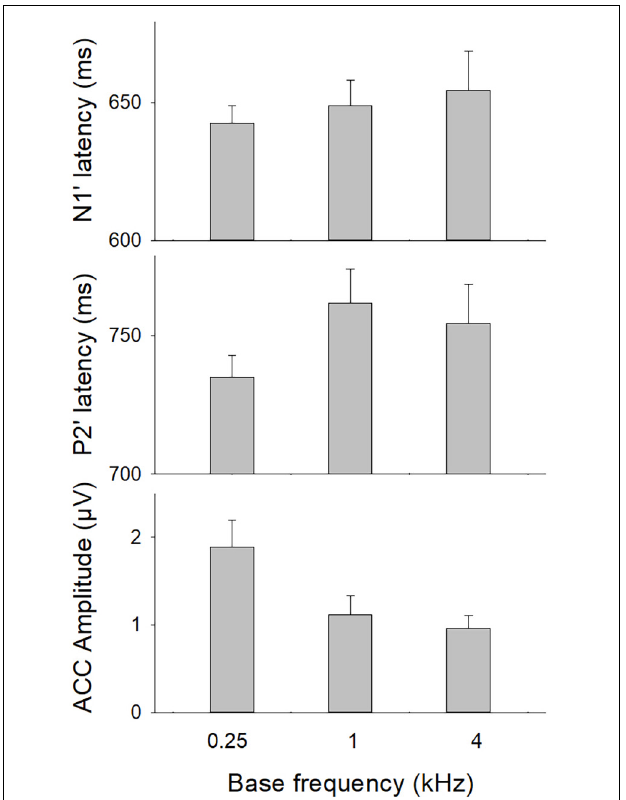
FIGURE 2 | The ACC measures (N1 (cid:48) and P2 (cid:48) latencies, N1 (cid:48) -P2 (cid:48) amplitude) at three base frequencies. Error bars indicate the standard error. A one-way repeated ANOVA was conducted separately for N1 (cid:48) latency, P2 (cid:48) latency, and N1 (cid:48) -P2 (cid:48) amplitude. Results showed that there was a statistical significance for N1 (cid:48) -P2 (cid:48) amplitude ( p < 0.01). Bonferroni follow-up test showed a larger ACC amplitude for 0.25 kHz than for other frequencies ( p <